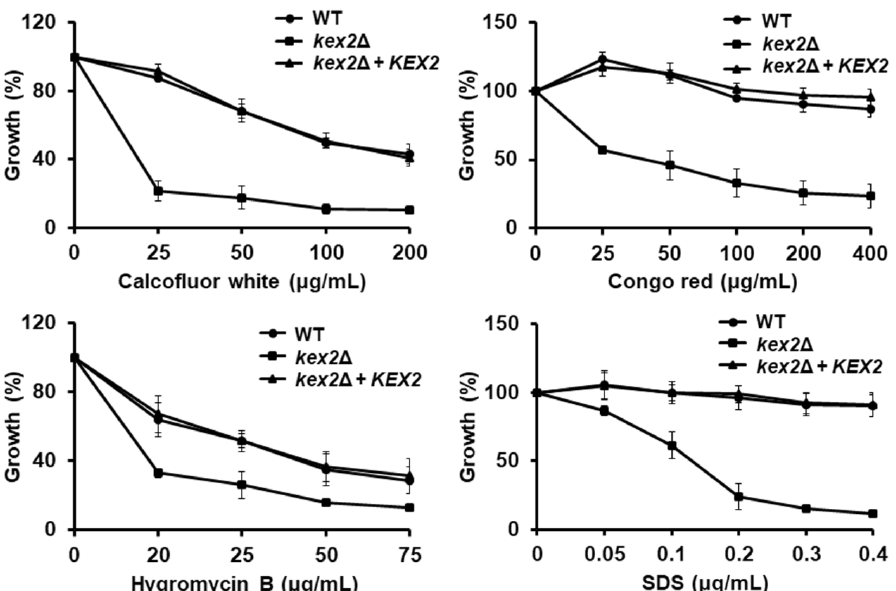
Figure 3. Susceptibility to calcofluor white, Congo red, hygromycin B, and sodium dodecyl sulfate in the Candida albicans kex2 Δ null mutant and control strains. Cells were incubated in Sabouraud broth supplemented with different concentrations of calcofluor white, Congo red, Hygromycin B, or sodium dodecyl sulfate (SDS) and cell growth was determined after incubation for 24 h at 30 °C. For normalization, growth results are shown as a percentage of those obtained with the same strain grown in the absence of any perturbing agent. Data are means ± SD of three independent experiments performed in duplicates. ( P < 0.01 when compared by two-way ANOVA). Strains used are NGY152 (WT), HMY209 ( kex2 Δ ) and HMY210 ( kex2 Δ + KEX 2).